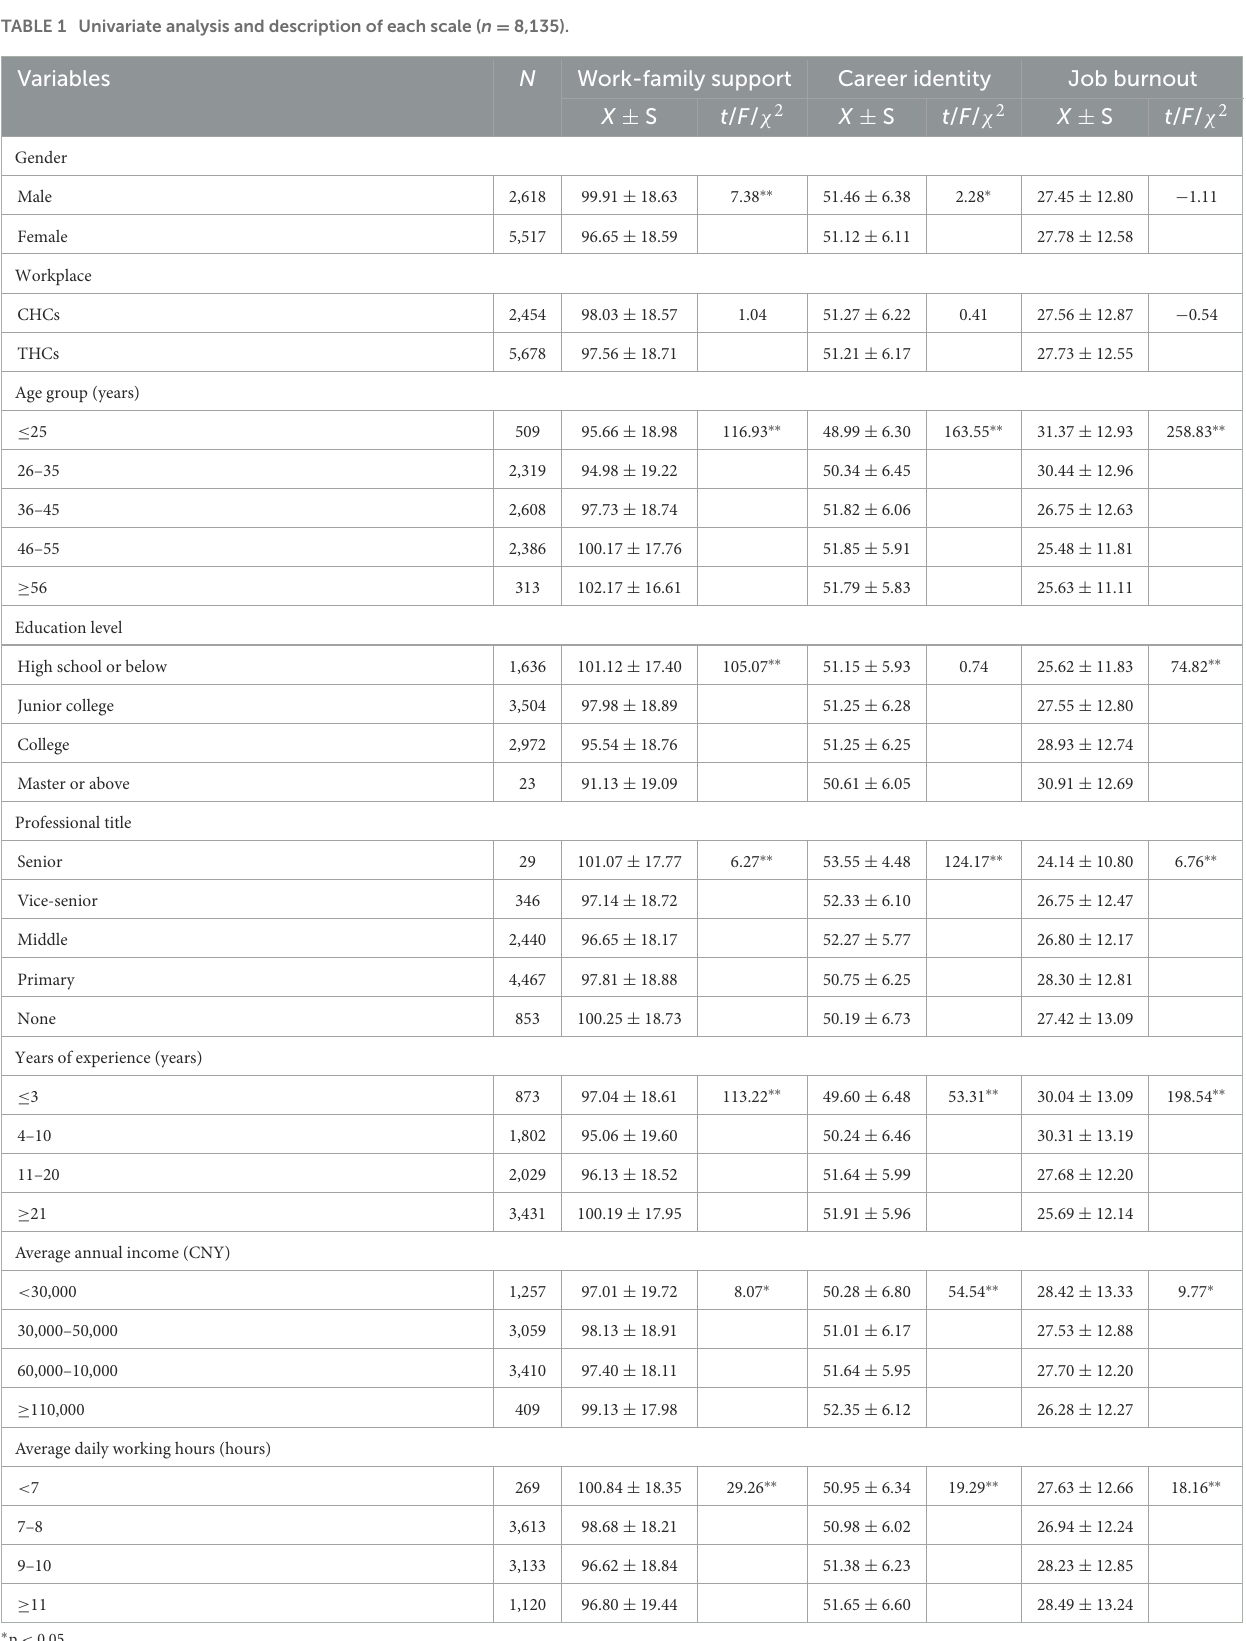
TABLE 1 Univariate analysis and description of each scale ( n =